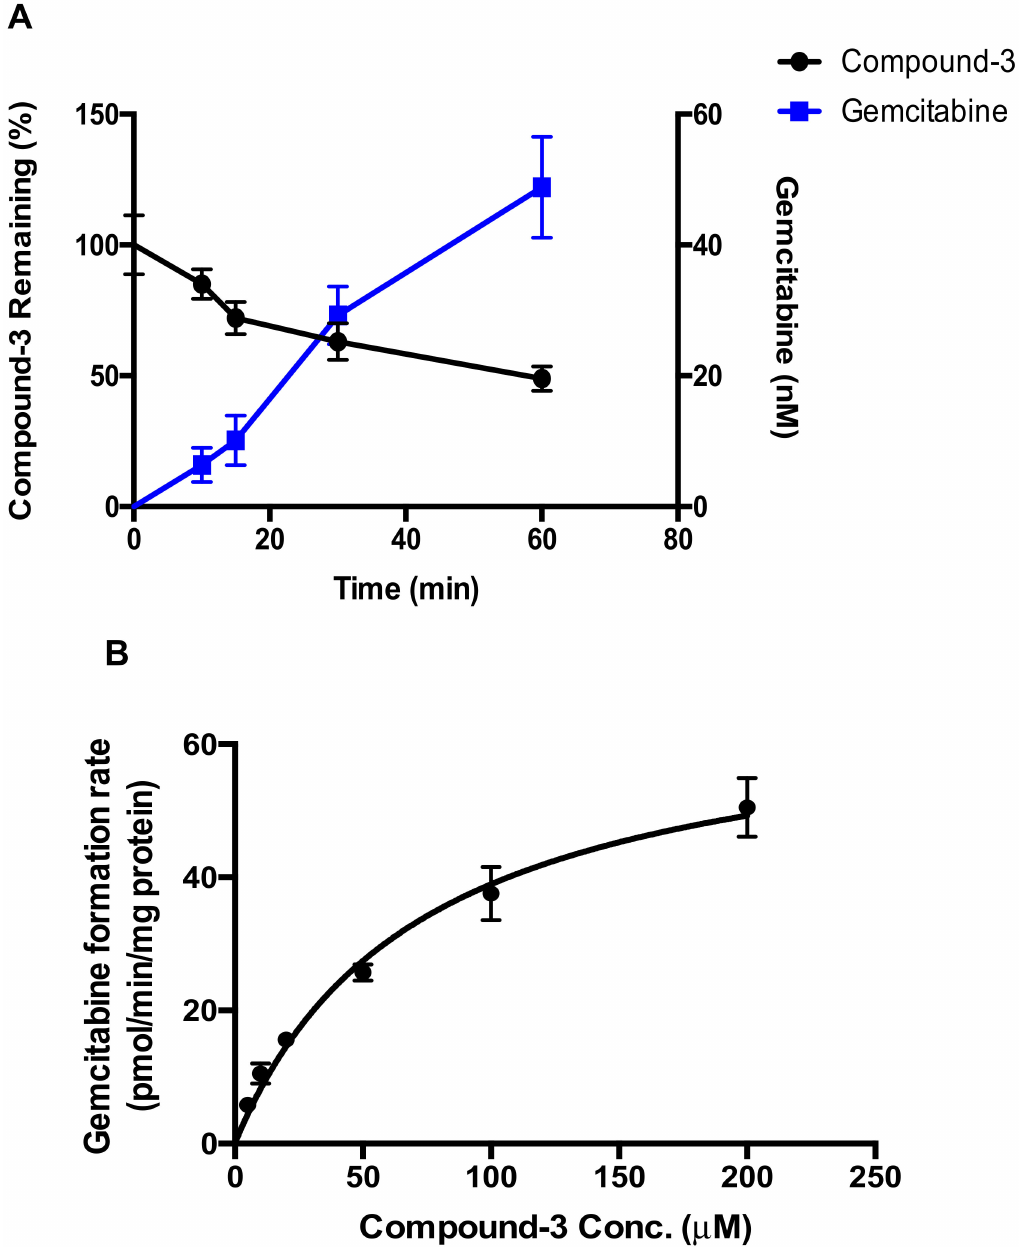
Figure 4. Hydrolysis of Compound- 3 by alkaline phosphatase. ( A ) Formation of gemcitabine. Compound- 3 (10 µ M) was incubated with alkaline phosphatase (0.1 mg/mL) for different time points at 37 ◦ C (n = 3); ( B ) Formation kinetics of gemcitabine by alkaline phosphatase (0.1 mg/mL) at various concentration levels for 60 min at 37 ◦ C (n =